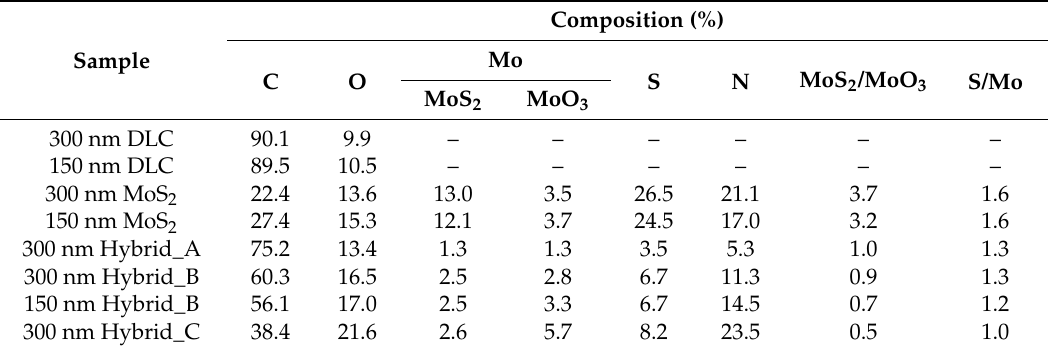
Table 4. Chemical compositions (C, O, Mo, S, and N) of the coatings.